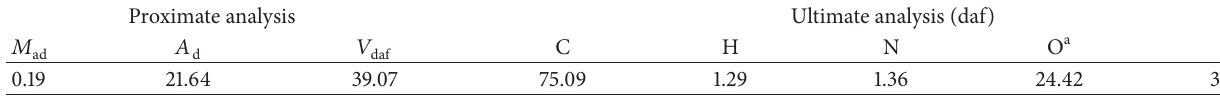
Table 1: Proximate and ultimate analyses ( W %) of HLR.